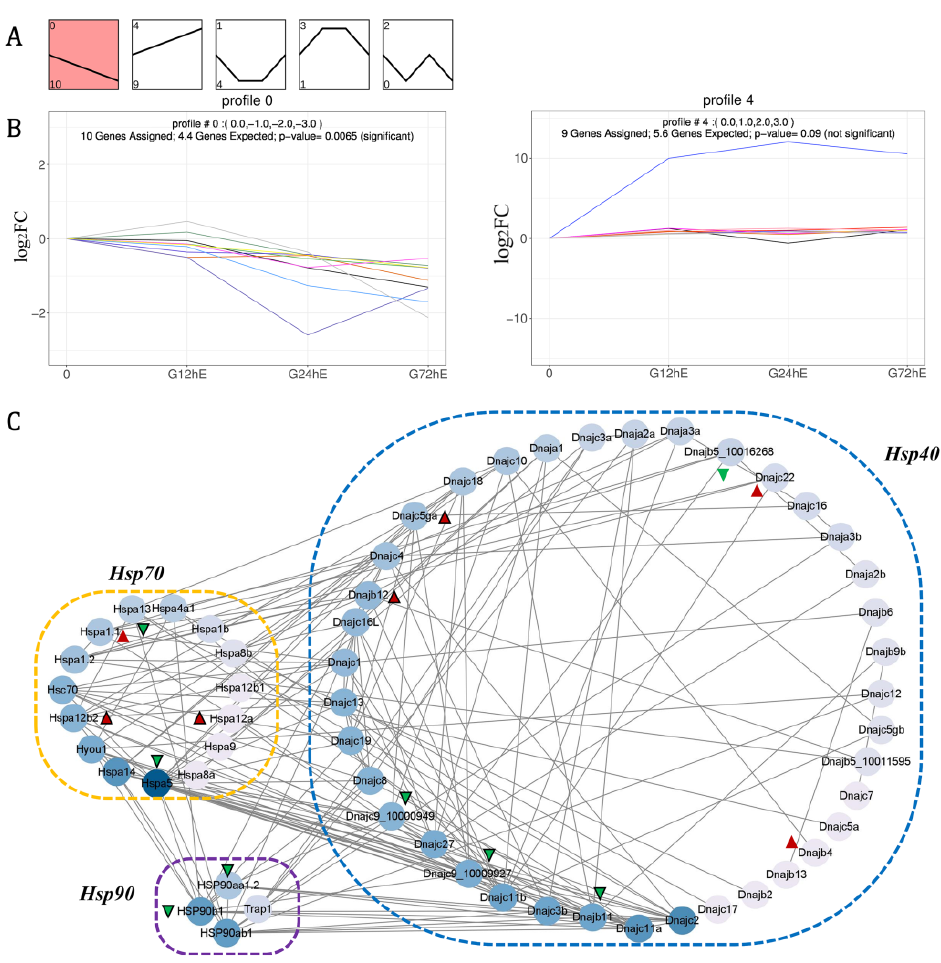
Figure 5. The expression trend and coordinated regulation of LmHsp40-70-90 co-chaperons in response to alkalinity stress. ( A ) Expression patterns enriched in five profiles with the number of LmHsp s indicated; ( B ) Expression trends of LmHsp genes enriched in the down-regulated profile 0 and up-regulated profile 4; ( C ) Protein-protein interaction (PPI) according to the PCC of LmHsp expression under alkalinity stress. Green and red triangles represent Hsp s from profiles 0 and 4, respectively, and triangles with black frame are the significantly regulated LmHsp s in response to alkalinity stress.